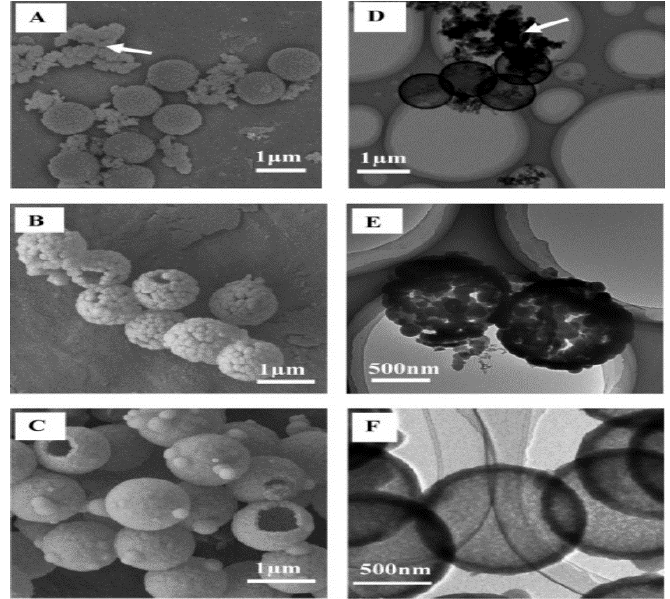
Figure 18. SEM ( A – C ) and TEM ( D – F ) images of the hollow silica when the TEOS concentration = 0.12 M and different pH. ( A , D ) pH 9, ( B , E ) pH 12, and ( C , F ) pH 13 [61]. 0.12 M and different pH. ( A , D ) pH 9, ( B , E ) pH 12, and ( C , F ) pH 13